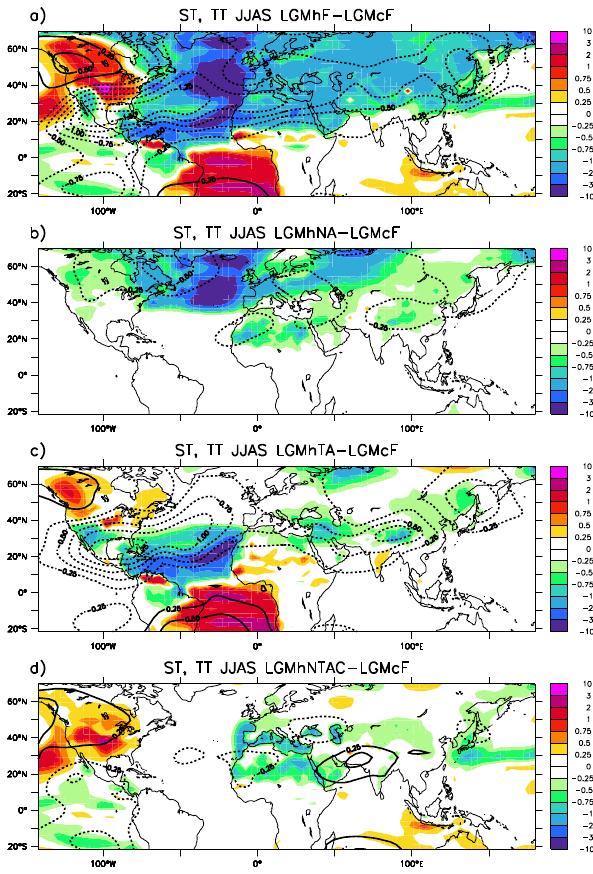
Fig. 5. Differences of JJAS surface temperature (ST, shaded) and tropospheric temperature averaged from 200 to 500hPa (TT, con- tours) between (a) LGMhF and LGMcF (hosing minus control ex- periment), (b) LGMhNA and LGMcF (North Atlantic minus con- trol experiment), (c) LGMhTA and LGMcF (tropical Atlantic minus control experiment), (d) LGMhNTAC and LGMcF (complementary minus control